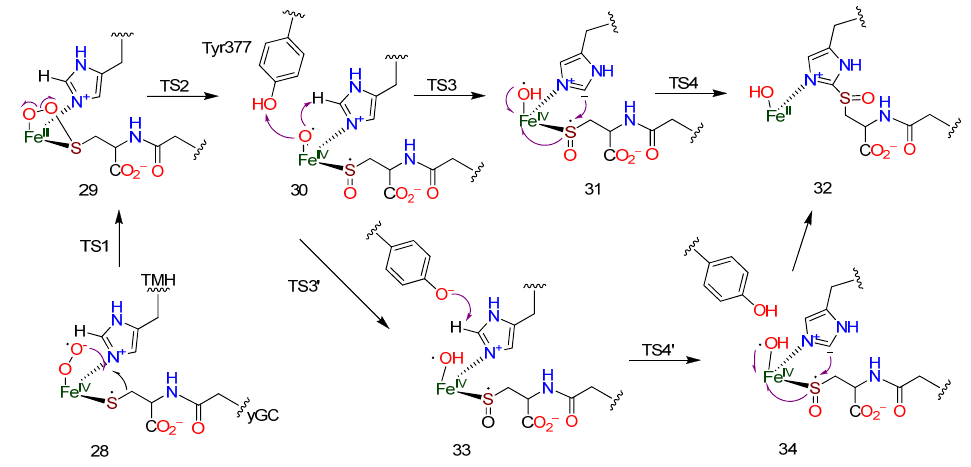
Figure 6. Postulated mechanism and transition states for EgtB based on QM/MM calculations (adapted from ref. [105]).